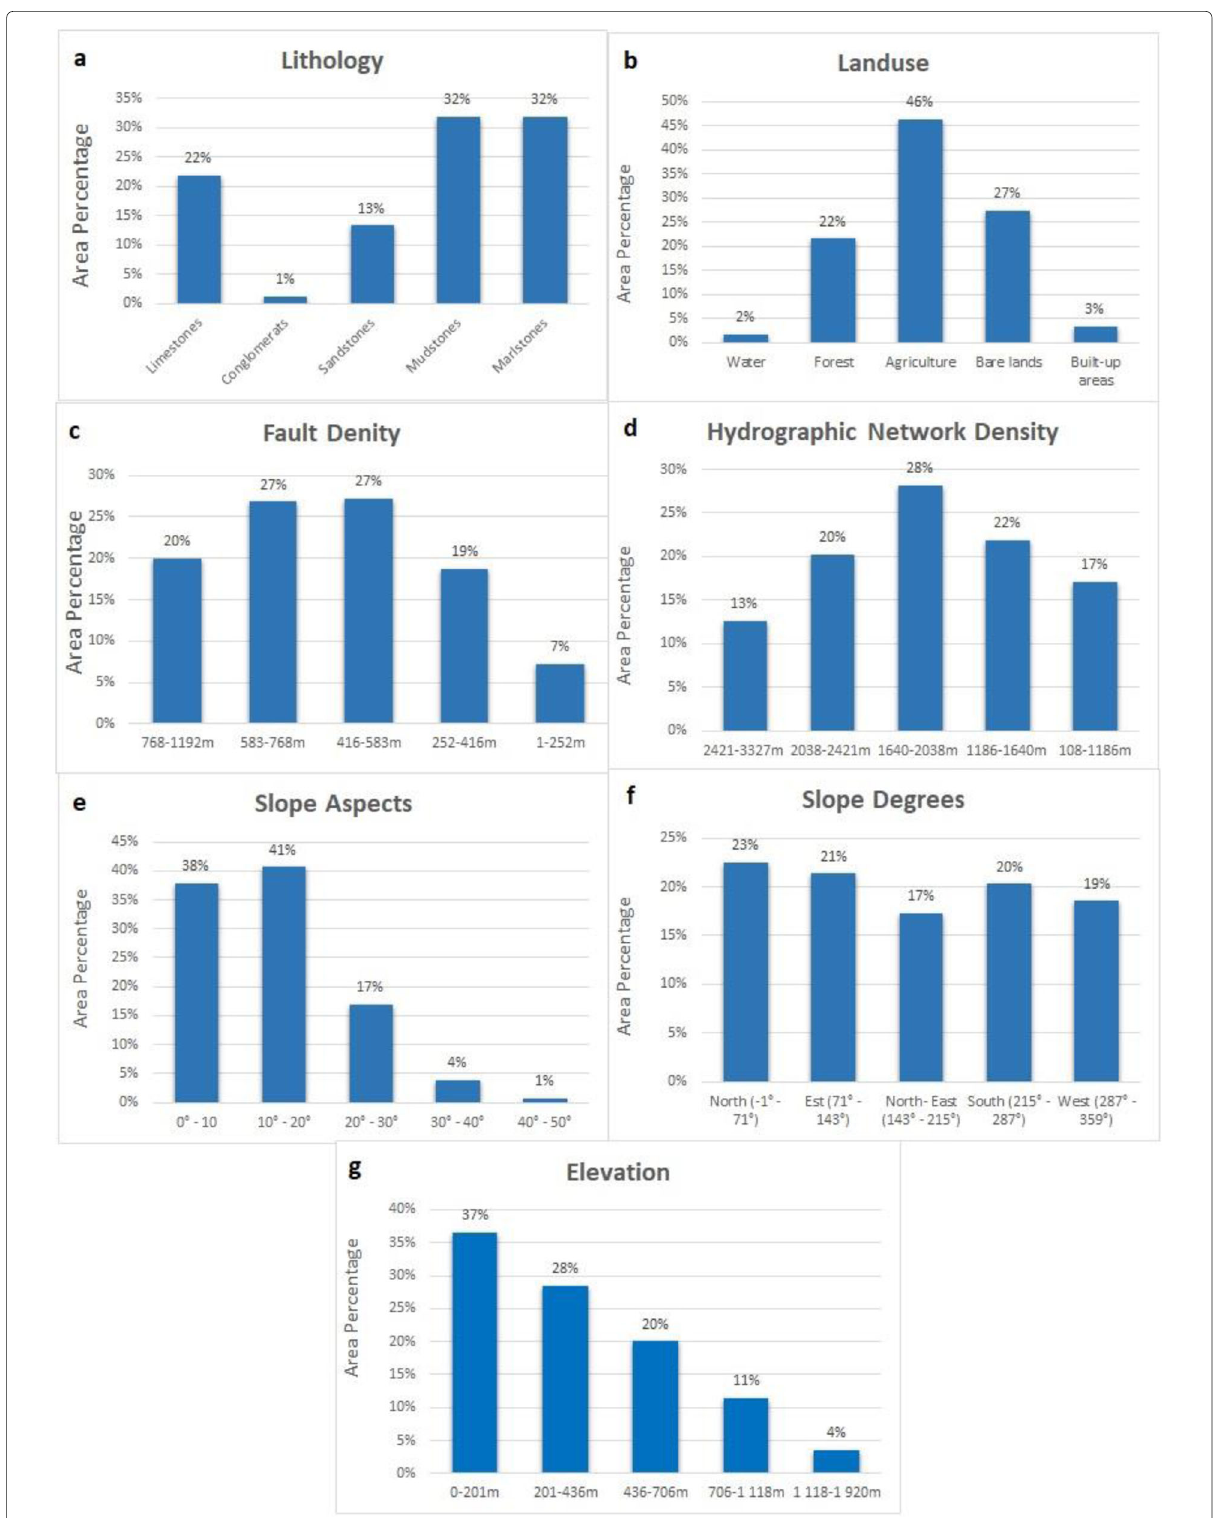
Fig. 7 Percentage of zones of seven predisposition factors in Tétouan